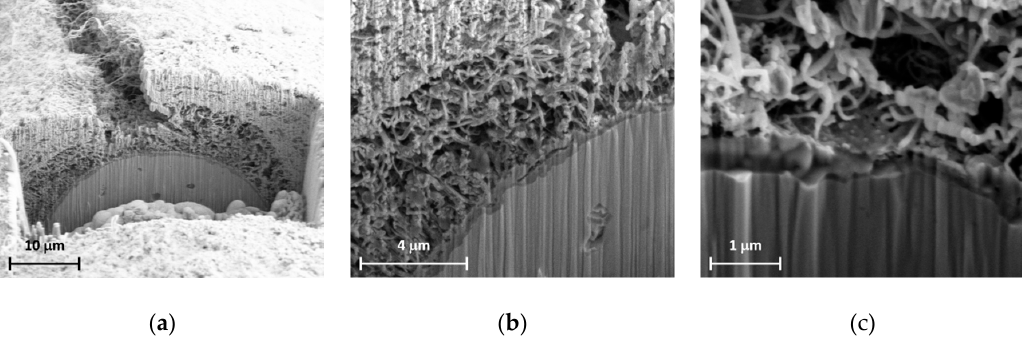
Figure 10. Cross-section SEM micrographs of FIB milled F3 inlet structured catalyst after DRM reaction at low ( a ), medium ( b ), and high magnification ( c ).